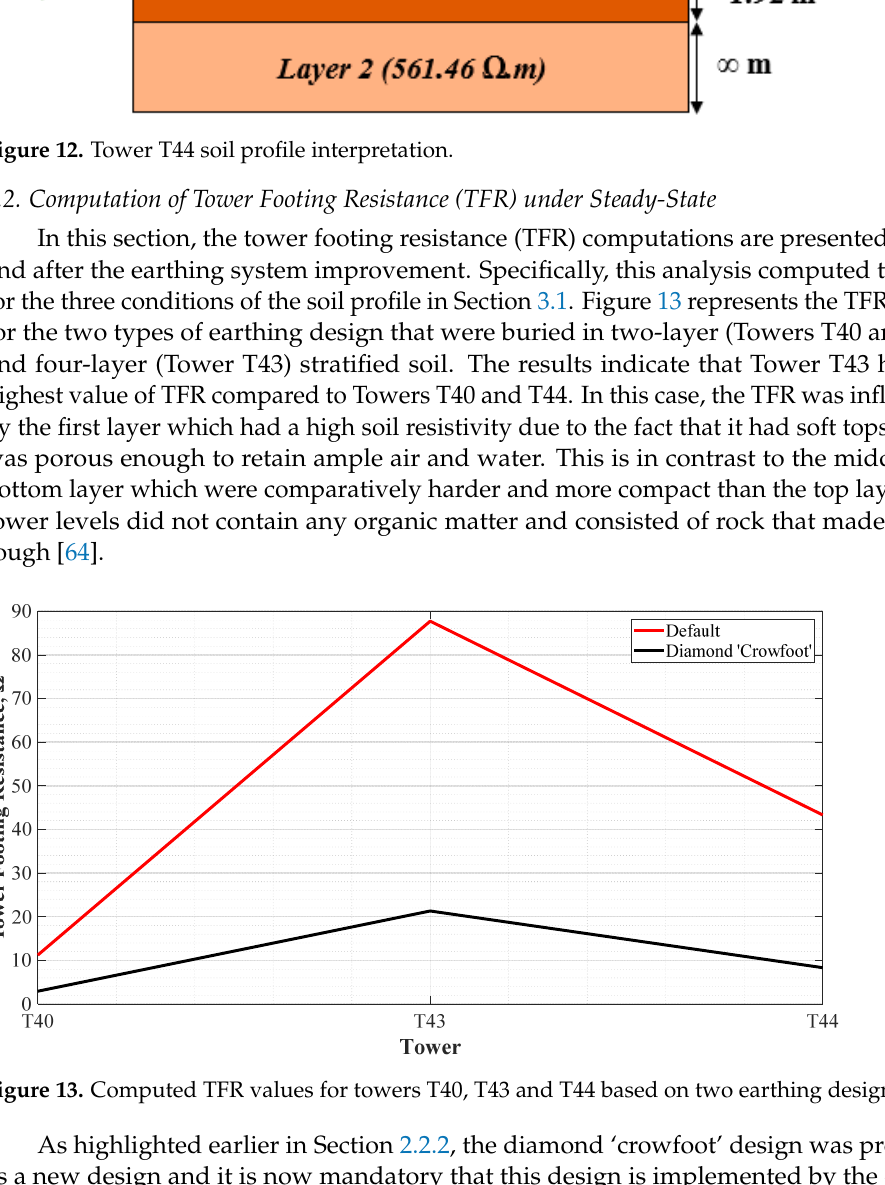
Figure 11. Tower T43 soil profile interpretation.